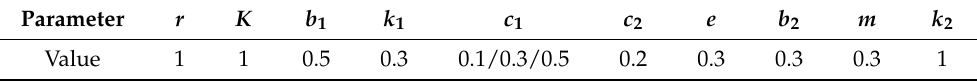
Table 2. Values of parameter to see the impacts of conversion rate of prey predation.